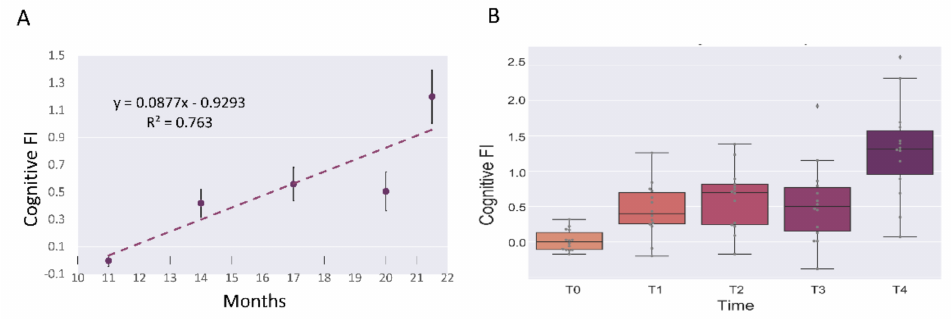
Figure 7. Mean cognitive decline, reported as Cognitive Frailty Index (FI), during physiological aging ( n = 14). ( A ): linear least-squares regression analysis of Cognitive FI during mice lifespan. ( B ): median value of Cognitive FI during mice lifespan.